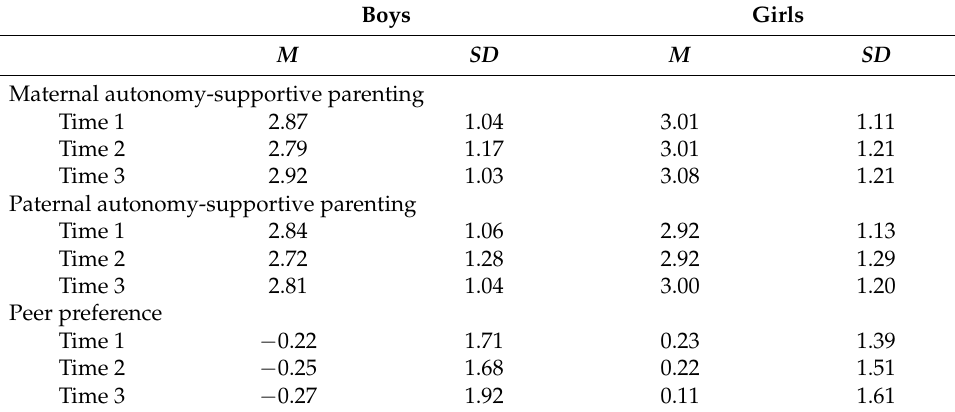
Table 1. Descriptive statistics for all study variables.